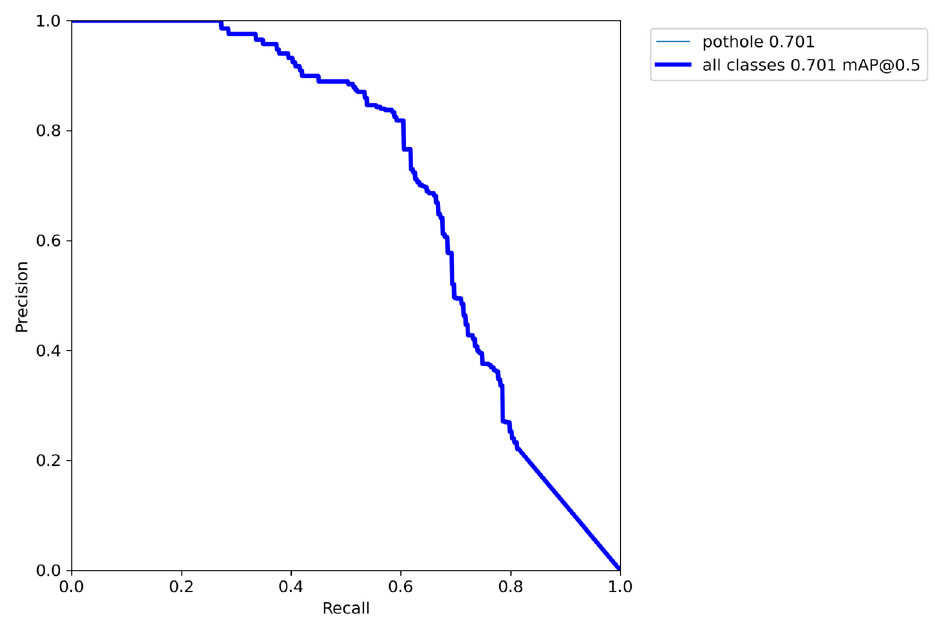
Figure 19. Precision–recall curve on a public dataset which only has images of potholes.